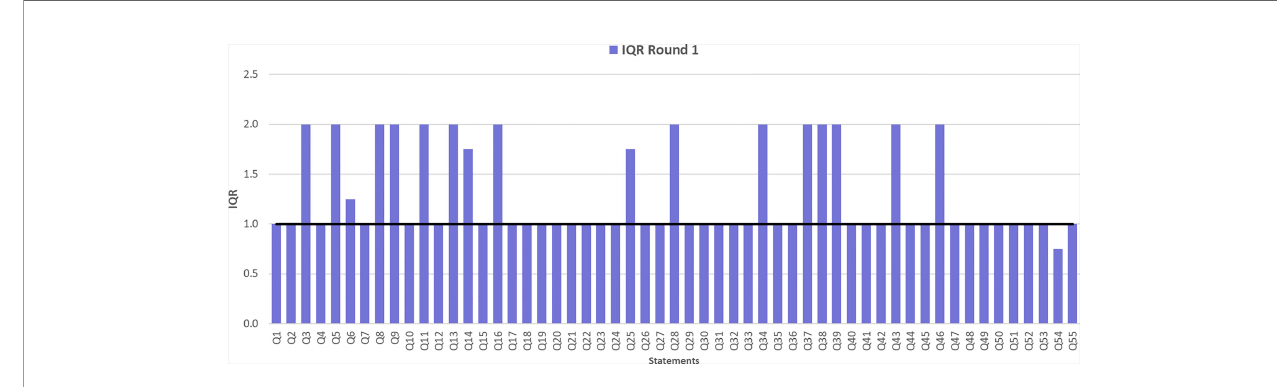
FIGURE 9 | IQR measure for all statements at Round